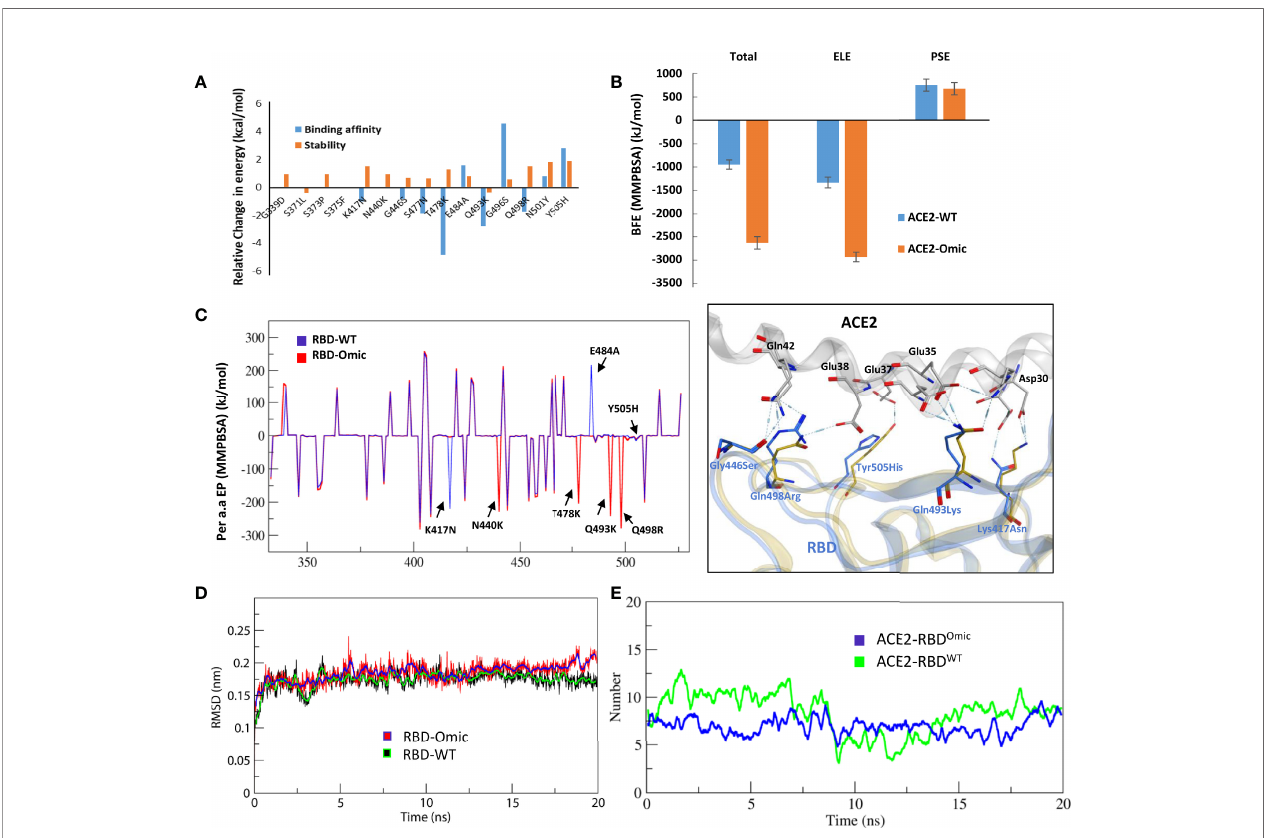
FIGURE 2 | Relative effect of mutations in Omicron RBD on the ACE2 binding. (A) Effect of 15 individual mutations on the binding and stability of RBD Omic – ACE2 was monitored relative to that of RBD WT – ACE2. (B) The binding free energies (measured through MMPBSA) as consequences of all 15 mutations at once were monitored for both RBD Omic – ACE2 and RBD WT – ACE2. (C) Per-residue energy contribution was monitored, and the hotspots of RBD were labeled. The change in the hydrogen bond network of the selected hotspots is shown at the right. (D, E) Root mean square deviation and hydrogen bonds at the RBD – ACE2 interface as a function of time are displayed for both RBD Omic – ACE2 and RBD WT – ACE2